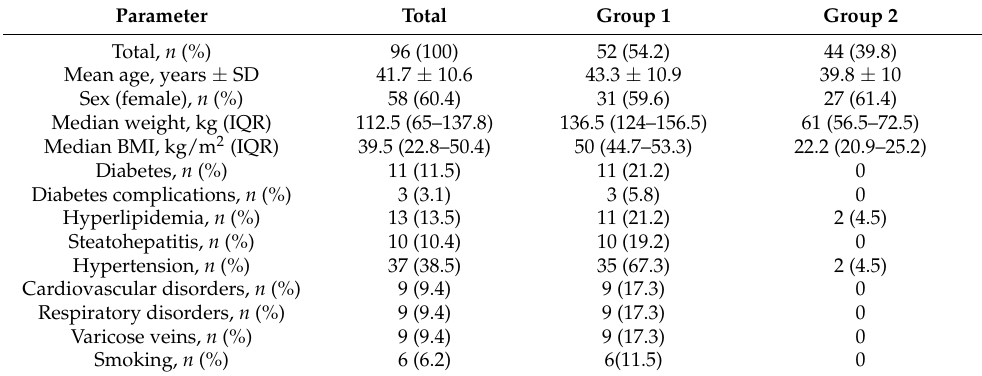
Table 1. Demographic